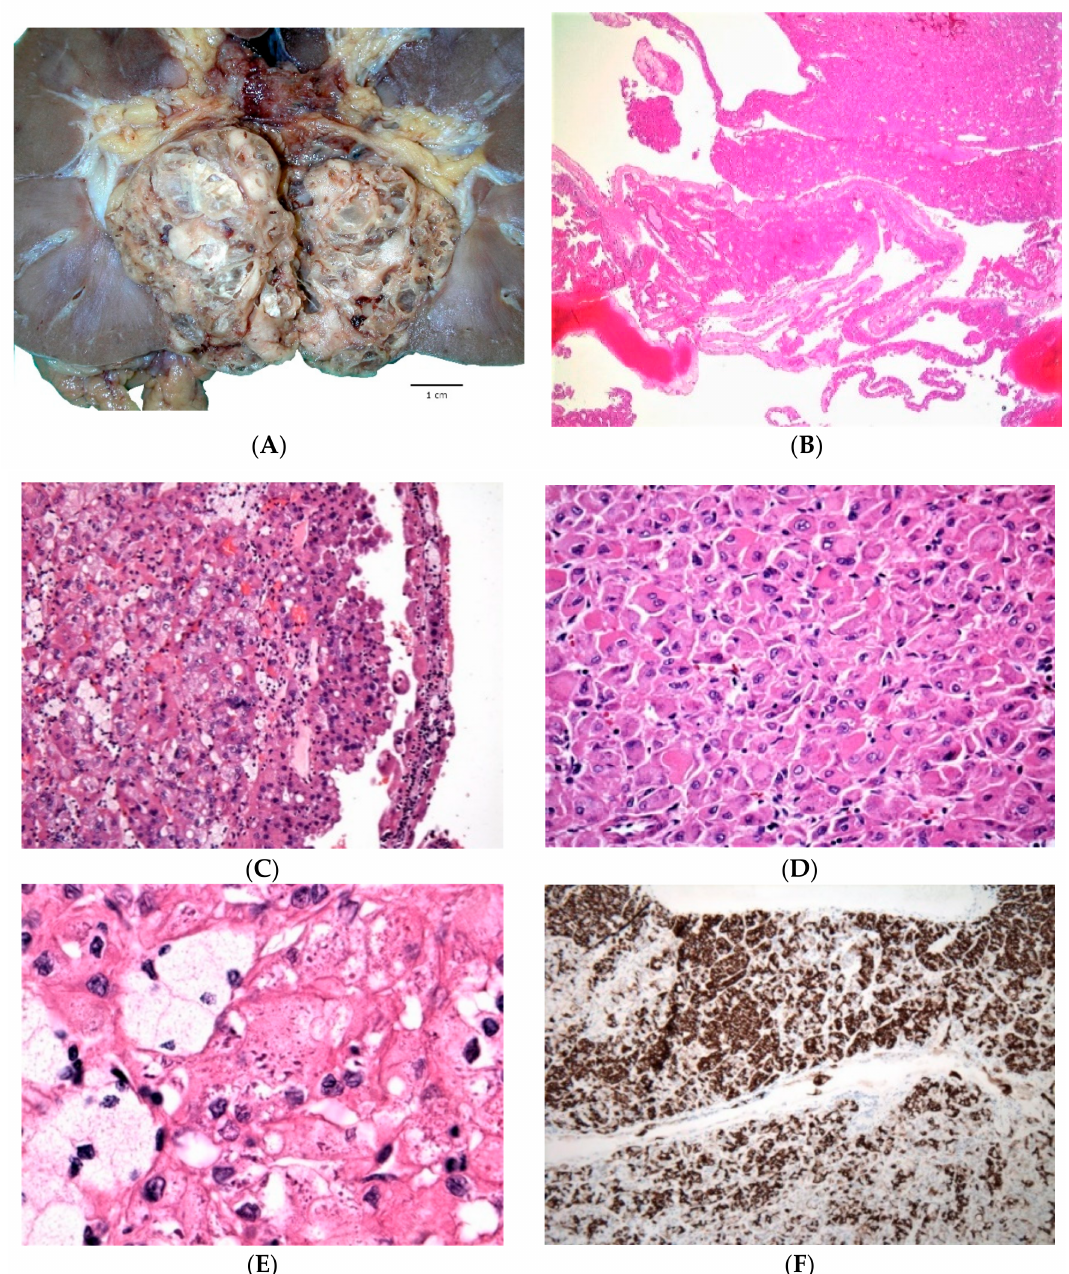
Figure 1. Eosinophilic solid and cystic renal cell carcinoma (ESC RCC) show grossly mixed macrocystic and solid appearances ( A ). Solid and cystic areas can also be appreciated at low power ( B ). The solid areas demonstrate di ff use and compact growth with adjacent cyst trabeculae showing hobnailing ( C ). Eosinophilic cells exhibit voluminous cytoplasm with readily recognizable coarse cytoplasmic granules (‘stippling’); aggregates of foamy histiocytes and lymphocytes are often found ( D , E ). CK20 is positive in the majority of ESC RCC ( F